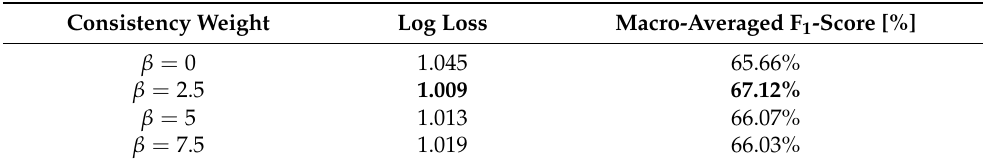
Table 4. Performance comparison with various consistency weights, β .